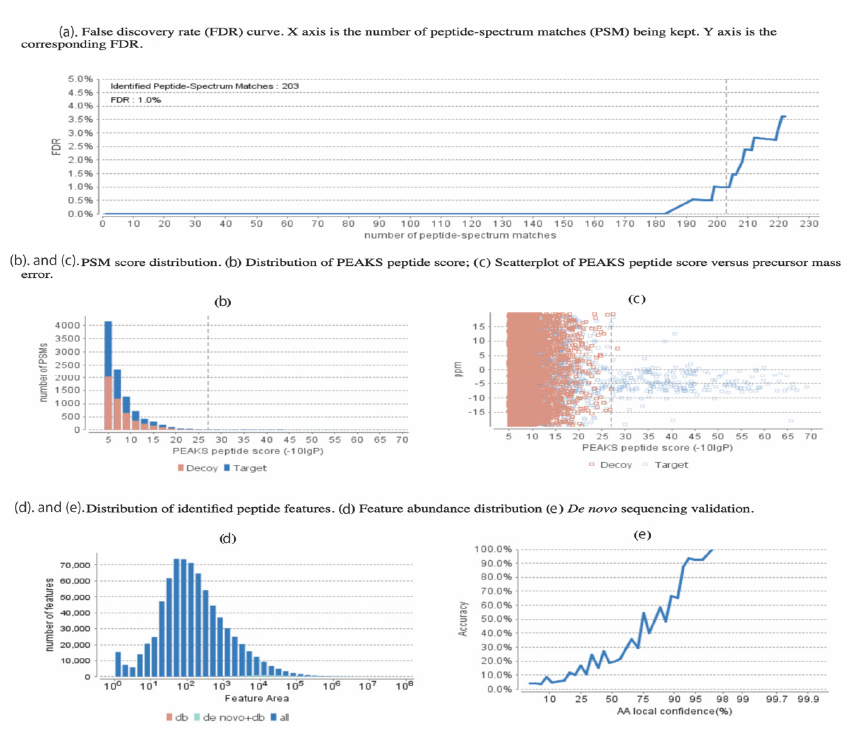
Figure 2. Statistical data presented from PEAKS analysis on the 17 proteins found uniquely in our study, with false discovery rate (FDR) set at 1%. ( a ) The false discovery rate (FDR) curve. The X -axis is the number of peptides-spectrum matches (PSM) being kept. The Y -axis is the corresponding FDR for the unique hits of our study. ( b ) Peptide-spectrum matches (PSM) score distribution, showing the distribution of the PEAKS peptide score. ( c ) The precursor mass error in ppm vs. − 10lgP peptide score for all the PSMs. ( d ) Distribution of abundance of identified peptides. ( e ) The de novo sequencing validation and accuracy level (ALC).